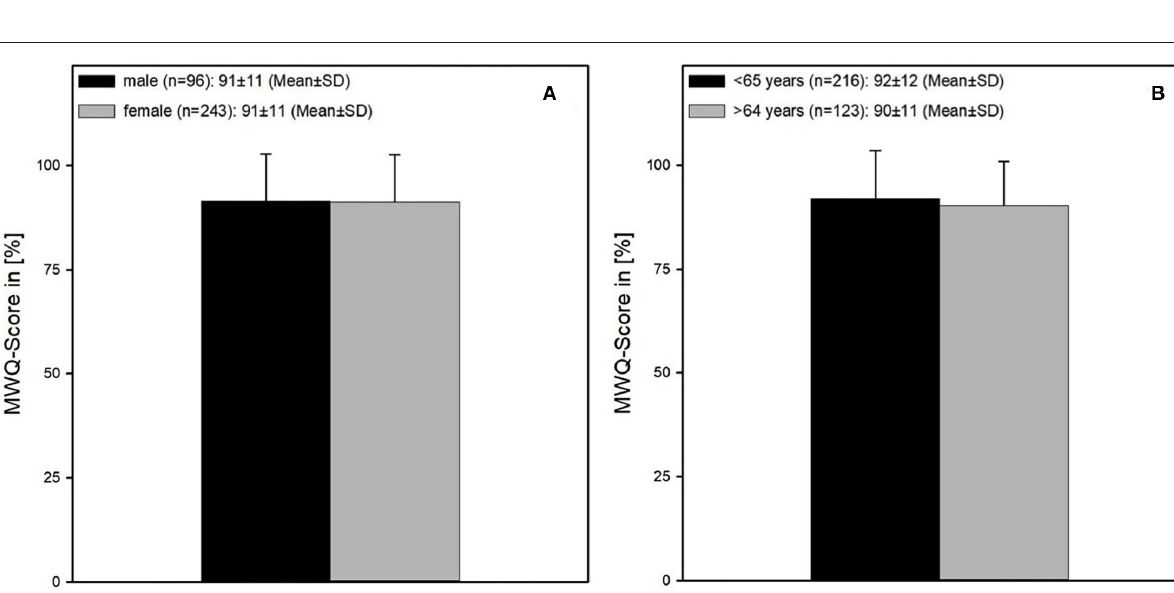
Frontiers in Surgery |